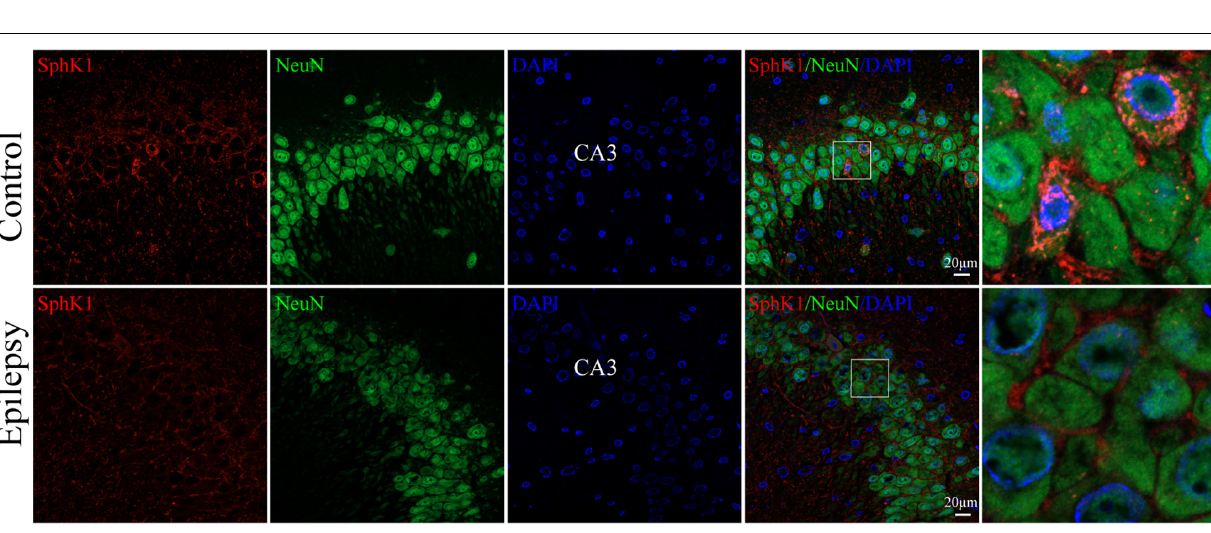
FIGURE 4 | Cellular localization of SphK1 in CA3 region of the hippocampus in epileptic rats. (left) Confocal images showing co-localization of SphK1 and DAPI in neurons. (right) Enlarged view of indicated co-localization between SphK1 with